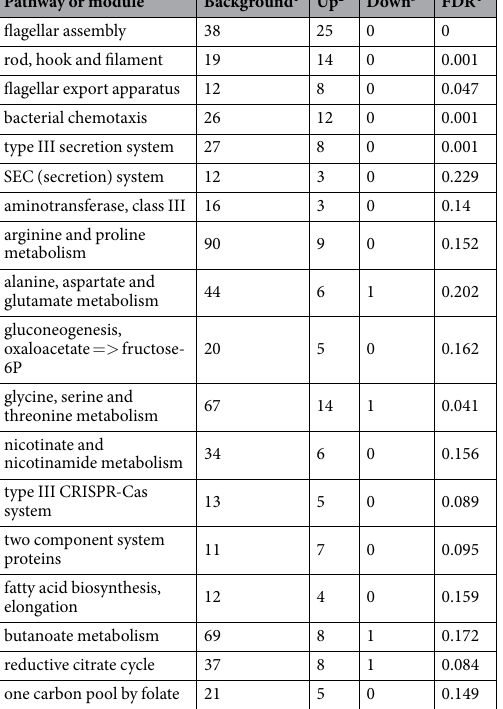
Table 1. Enriched KEGG pathways in periodontitis. Gene sets with FDR ≤ 0.25 and number of expressed genes ≥ 10 are shown. Gene set enrichment was performed as described in Materials and Methods. 1 Number of expressed KO genes in periodontitis for each enriched pathway. 2 Number of up-regulated KO genes in periodontitis for each enriched pathway. 3 Number of down-regulated KO genes in periodontitis for each enriched pathway. 4 FDR of statistical test for the gene set emrichment